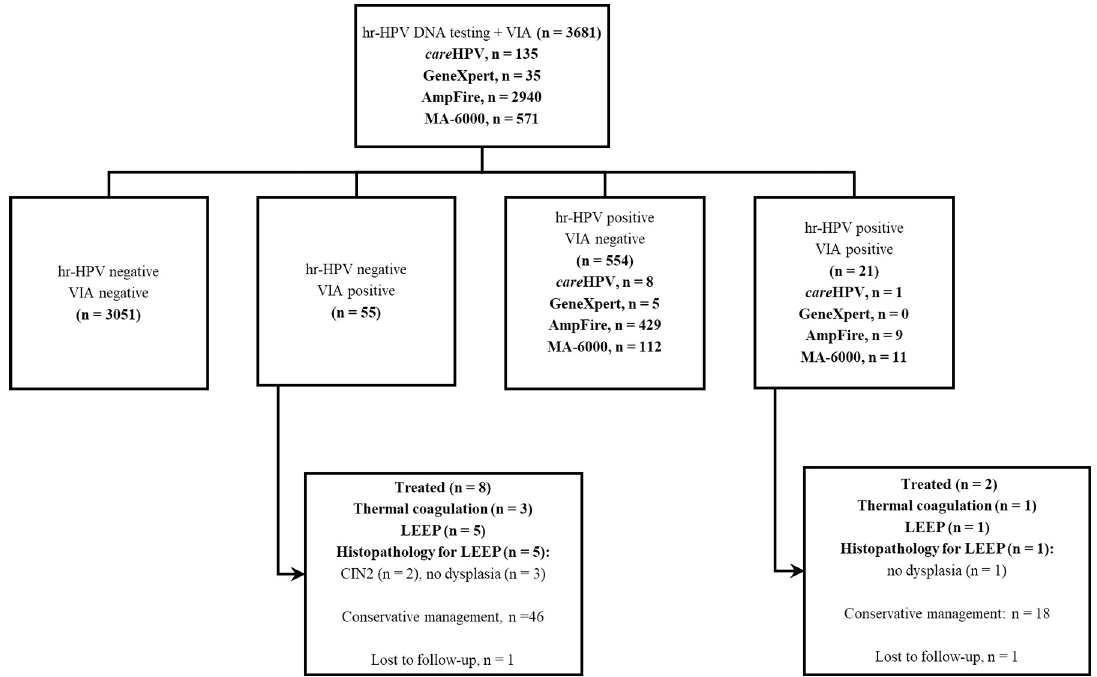
Fig 1. Flow chart for concurrent screening with hr-HPV DNA testing and VIA. VIA, visual inspection with dilute acetic acid; hr- HPV, high-risk human papillomavirus; LEEP, loop electrosurgical excision procedure.